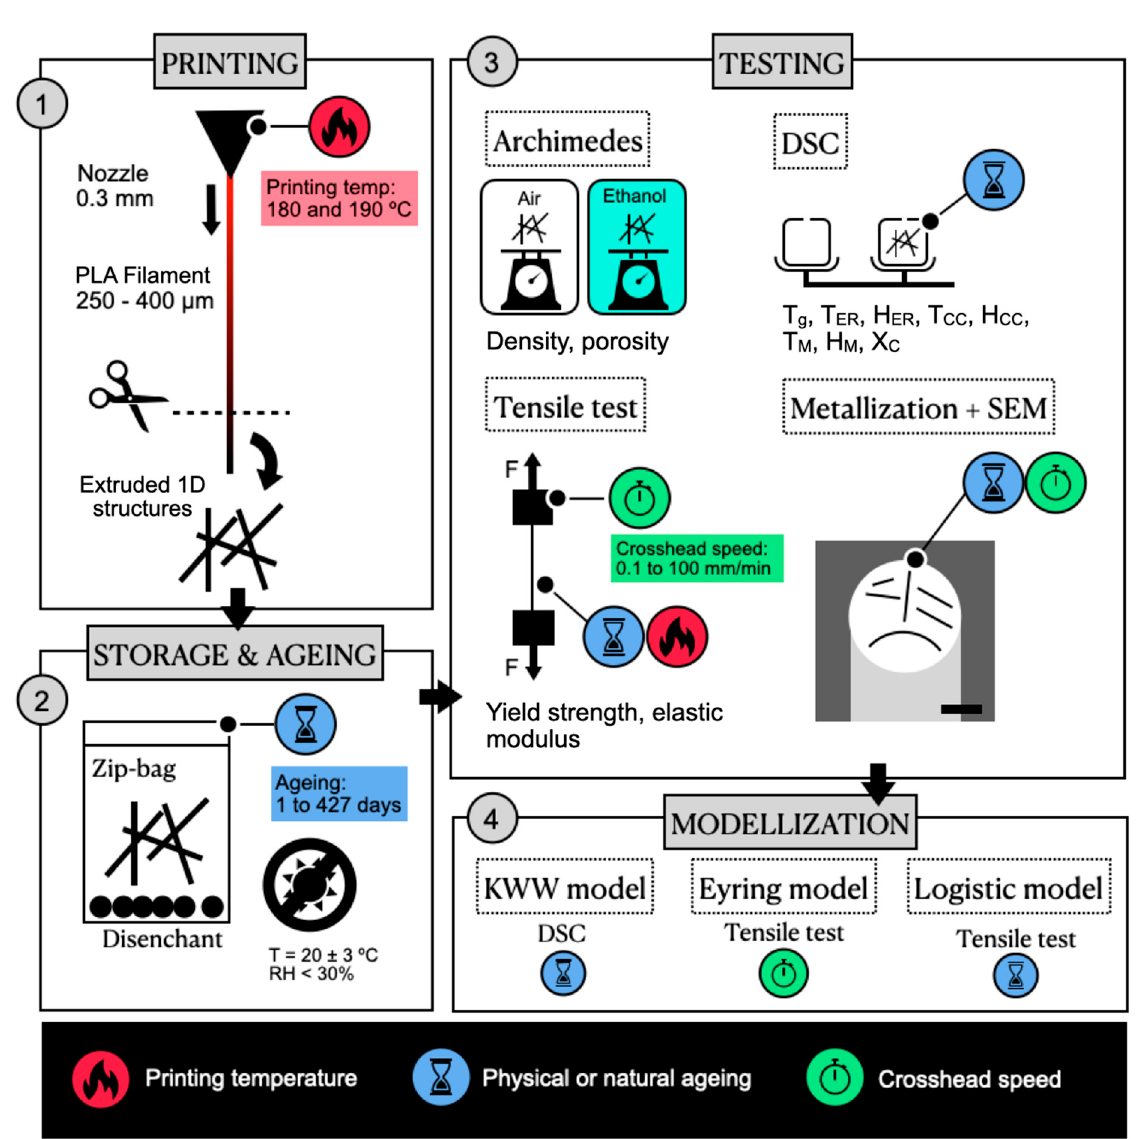
Figure 1. Summary of the Materials and Methods section. The material was extruded, stored, and tested, analysing the influence of the printing temperature, ageing time, and crosshead speed. The thermal and mechanical properties were modelled following the Eyring model, the Kohlraushch–William–Watts (KWW) model, and a logistic model.